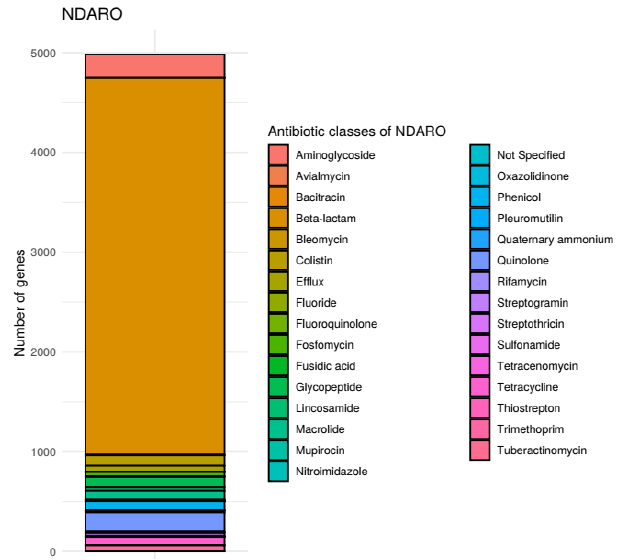
Figure S2. NDARO gene counts of each antibiotic class. Number of resistance genes were determined for each class of antibiotics stored in the NDARO database. Only antibiotic- and biocid resistance genes were considered for this plot.